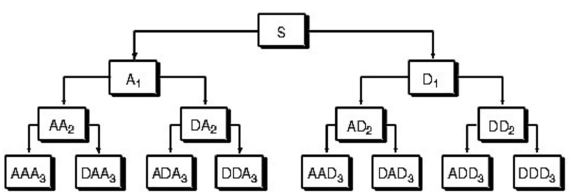
Figure 1. Three-layer wavelet packet